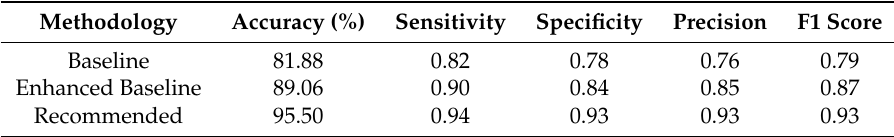
Table 12. Hold-out validation results using ResNet50.